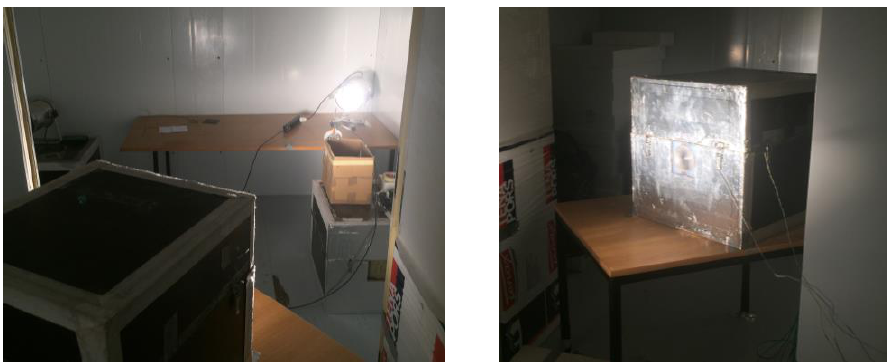
Fig. 4. Experimental setup.